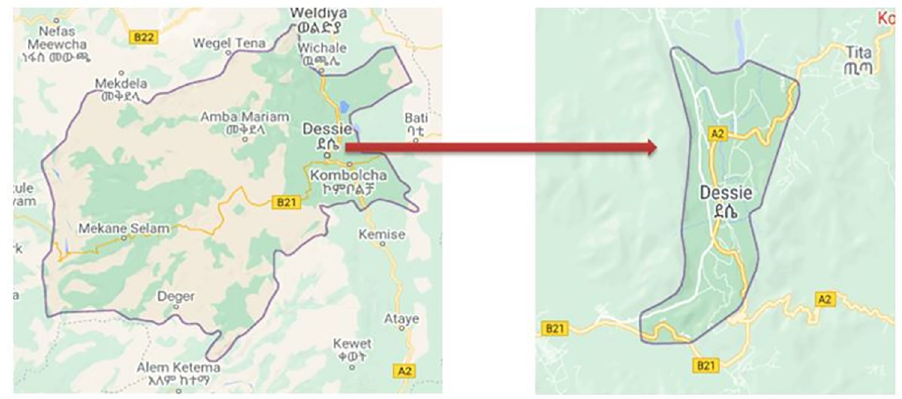
Fig 1. Map of Dessie town (source; Google map, Available at: https://www.google.com/search?q=south+wollo +map&source=lmns&bih=654&biw=1366&client=firefox-b e&hl=en&sa=X&ved=2ahUKEwjyyfmwgMryAh